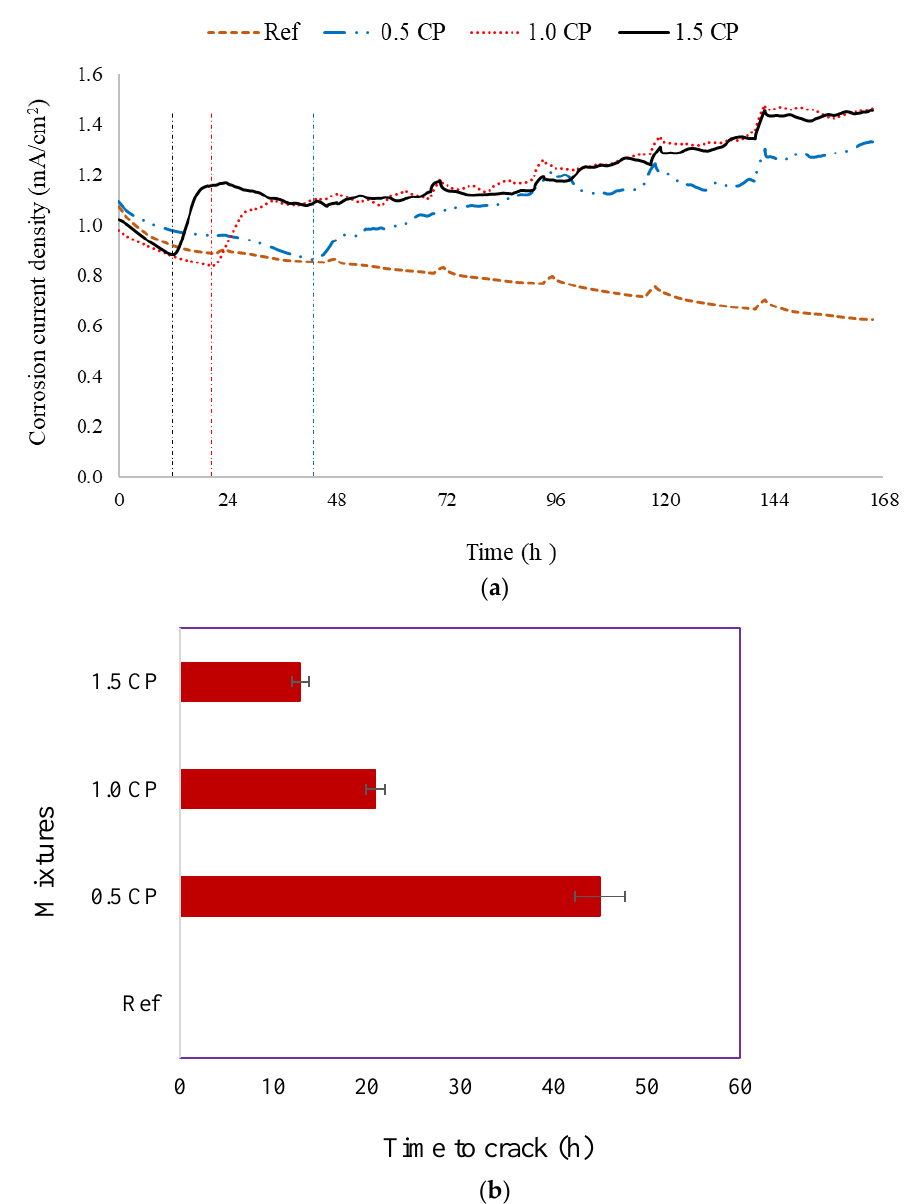
Figure 3. ( a ) Corrosion current density versus time plot. ( b ) Crack occurrence time.